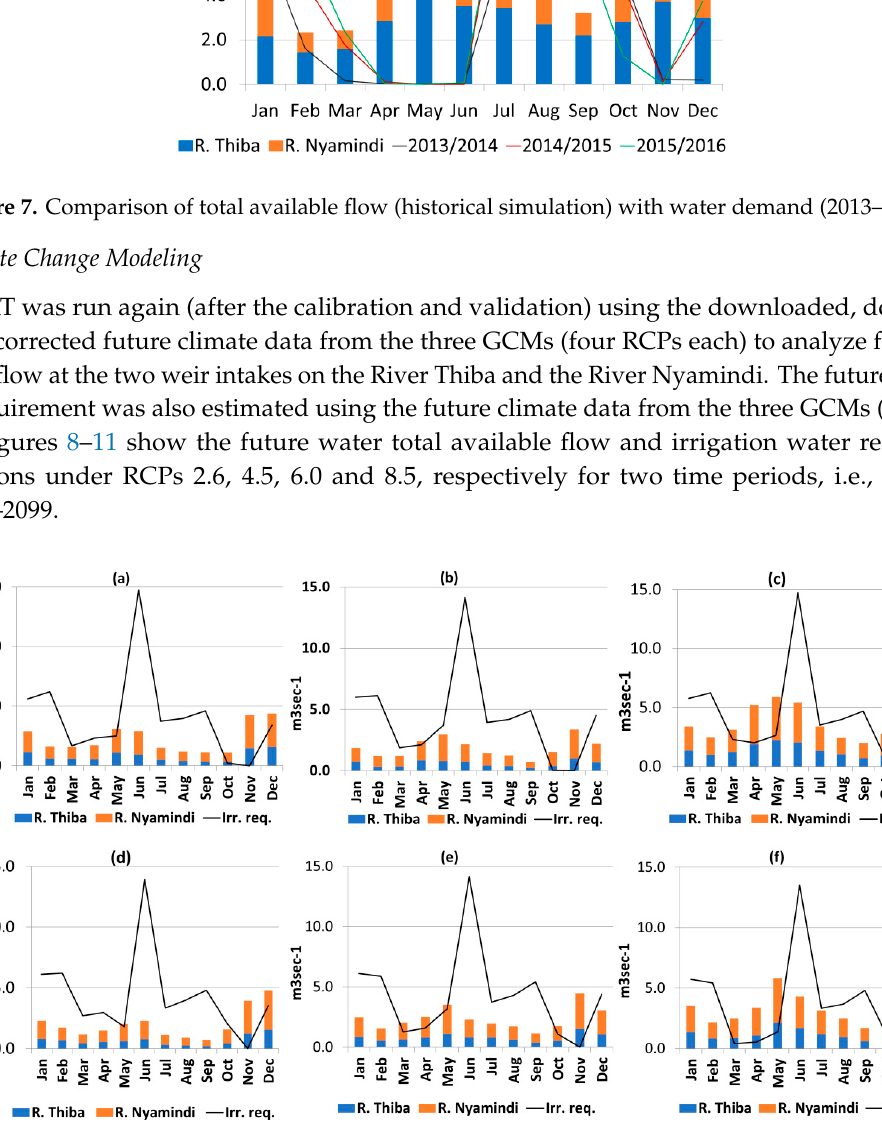
Figure 9. RCP 4.5 Comparison of total available flow and irrigation water requirements during 2020–2060 and 2061–2099. ( a ) GCM 1 (2020–2060); ( b ) GCM 2 (2020–2060); ( c ) GCM 3 (2020–2060); ( d ) GCM 1 (2061–2099); ( e ) GCM 2 (2061–2099); ( f ) GCM 3 (2061–2099).